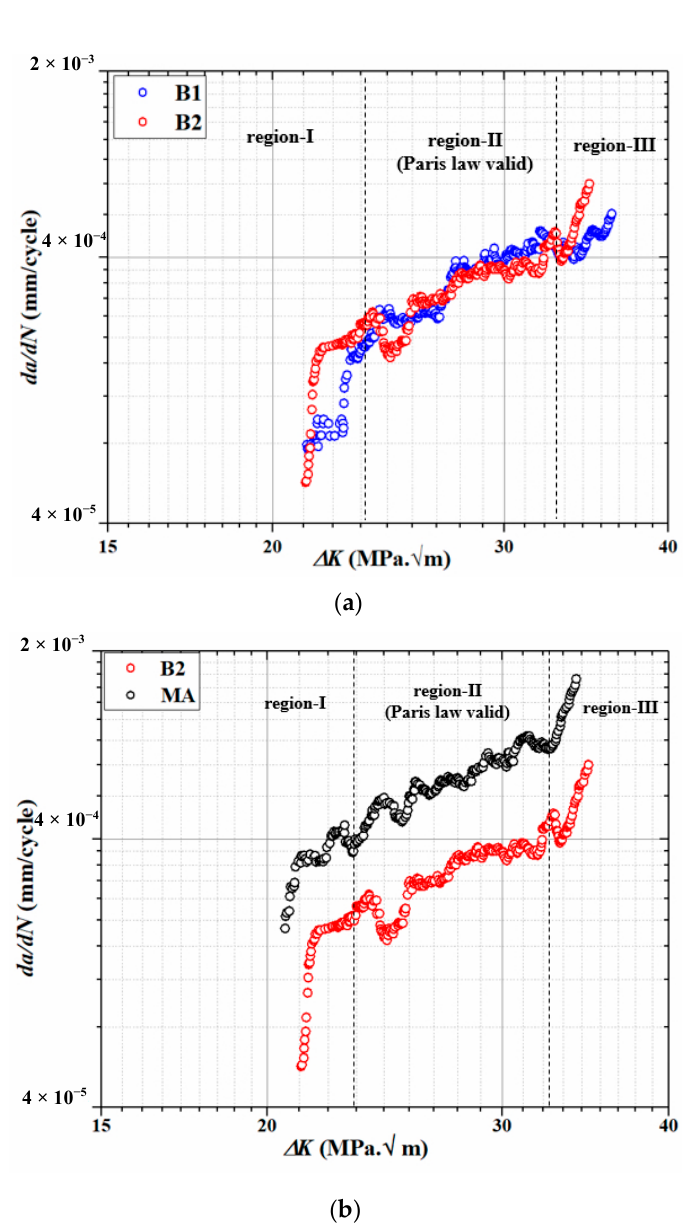
Figure 6. da/dN- Δ K curves of Ti-6Al-4V ELI for ( a ) B1 and B2, and( b ) B2 and MA.